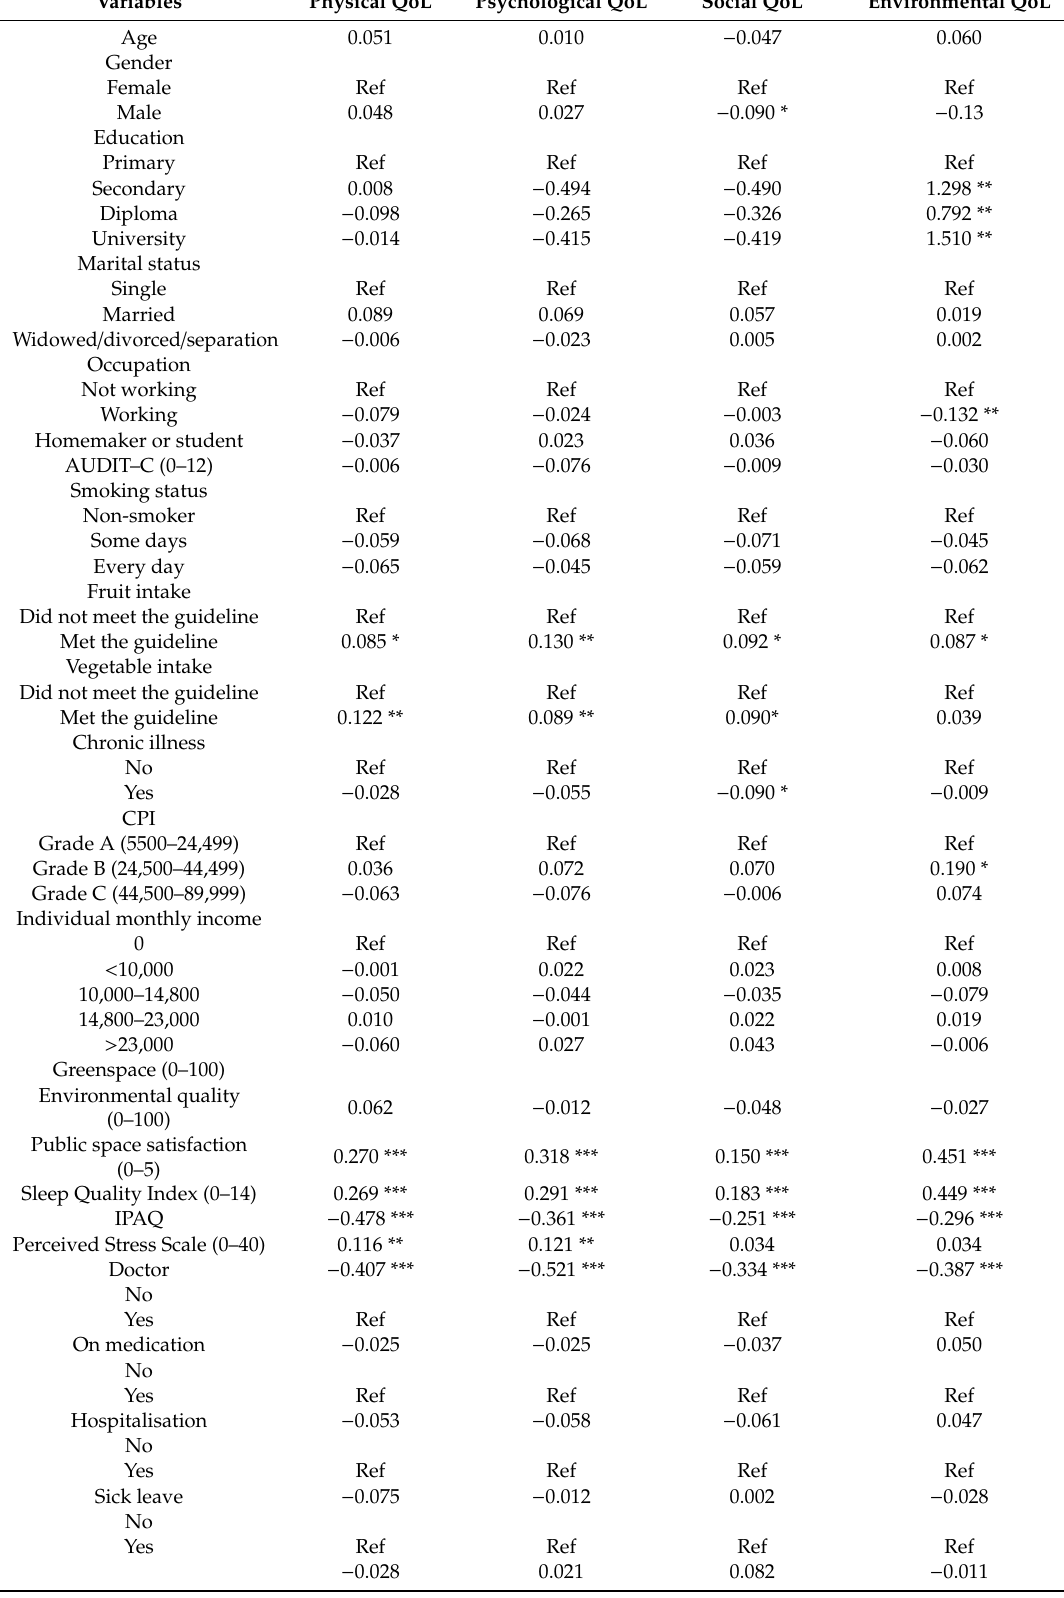
Table 2. Univariate analysis (linear